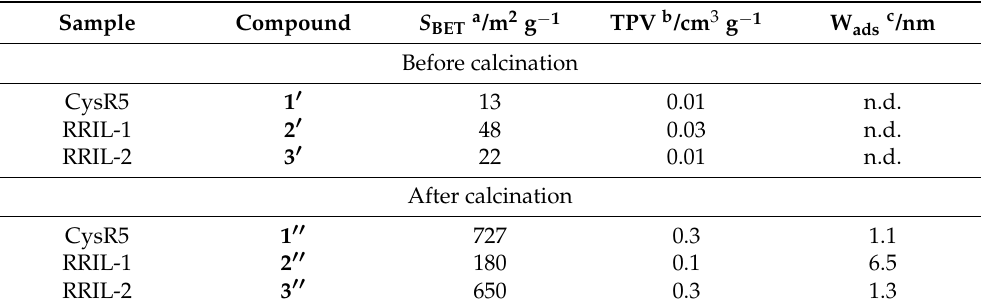
Table 3. Physicochemical properties of the silica-based particles obtained from nitrogen adsorption ( − 196 ◦ C) before and after